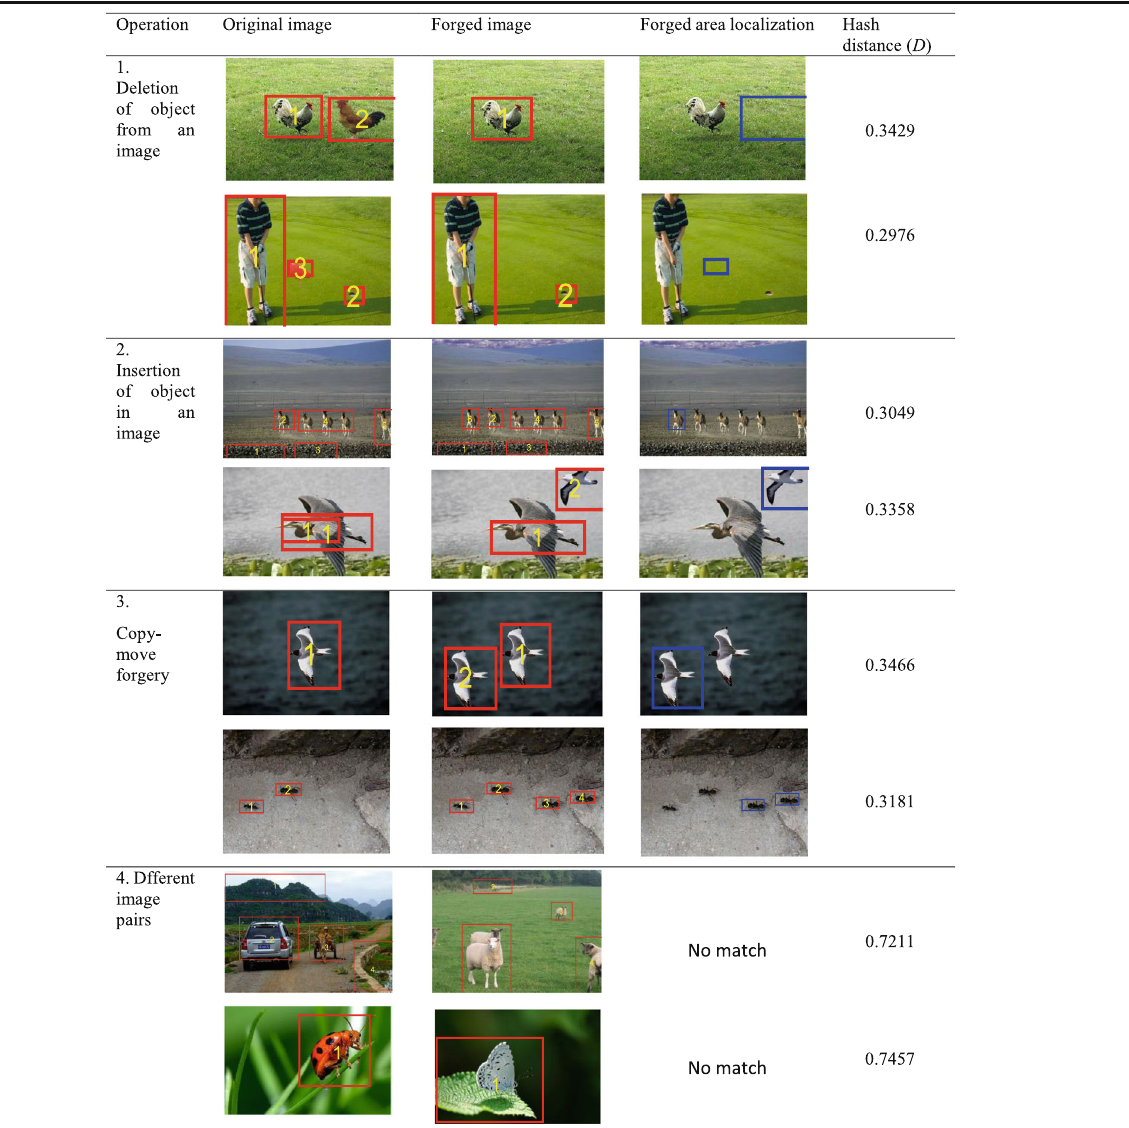
Table 5 Sensitivity towards forged images and localized